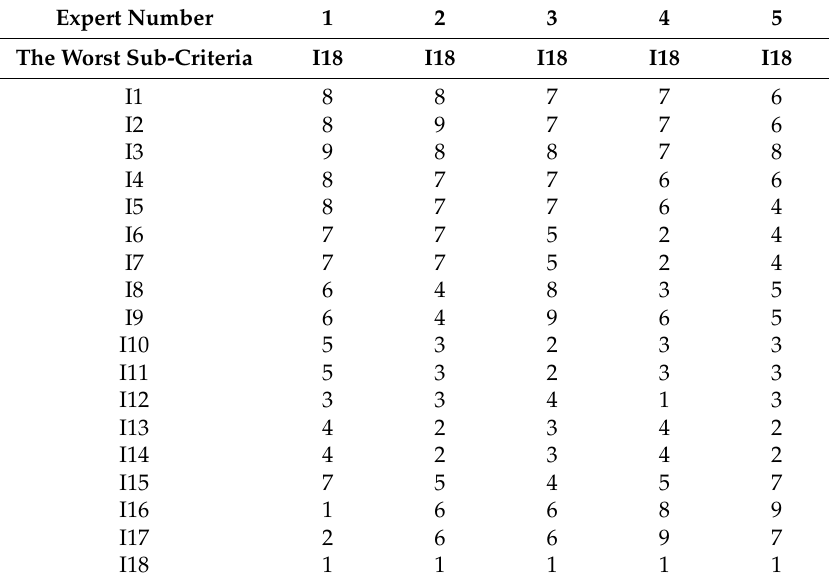
Table 9. The significant degree between others and the worst sub-criterion. Expert